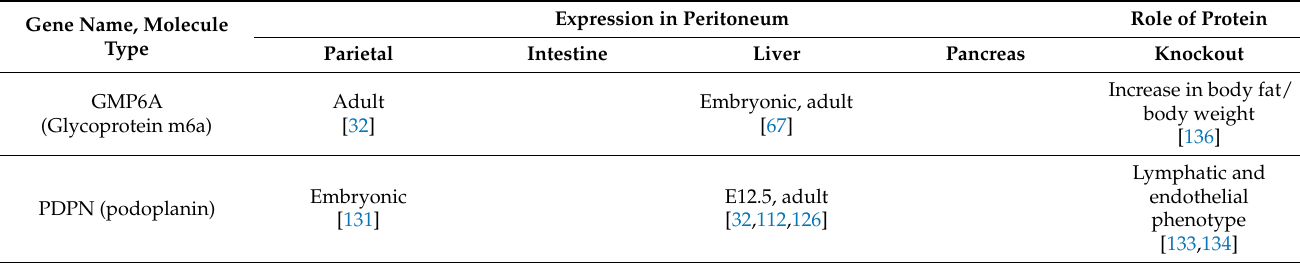
Table 1. Expression and function of mesothelial molecular markers during